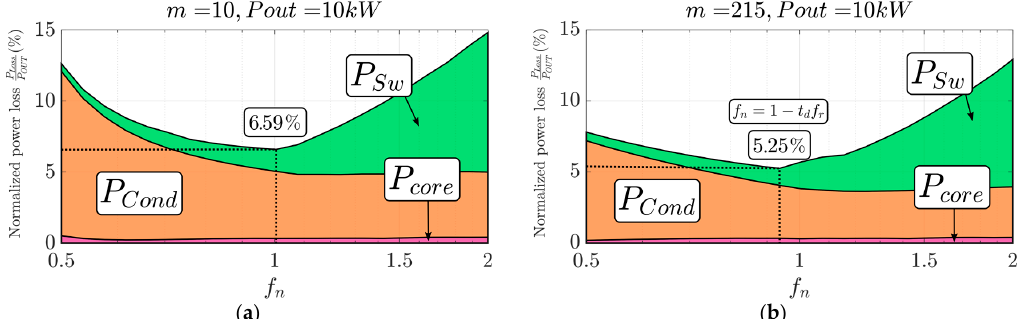
Figure 5. LLC converter total normalized power losses ( P Loss / P OUT ) at 10 kW output power. Including primary and secondary transistors and transformer. ( a ) for m = 10; ( b ) for m = 215.